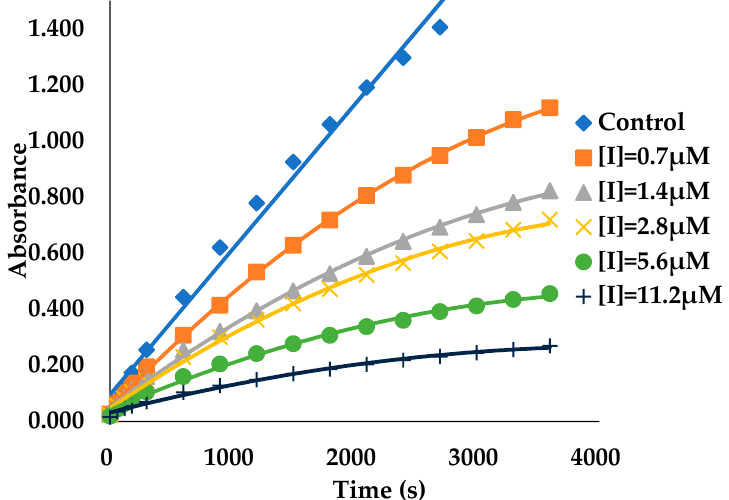
Figure 3. Progress curves of ECG binding to AGH in the presence of 0.36 mM pNPG. The progress curves were recorded in the presence of 0.7, 1.4, 2.8, 5.6, 11.2 µM of ECG. Control is progress curve in the absence of ECG. The reaction progress curves in the presence of 0.18, 0.72 and 1.44 mM of substrate concentrations are not given in this article.